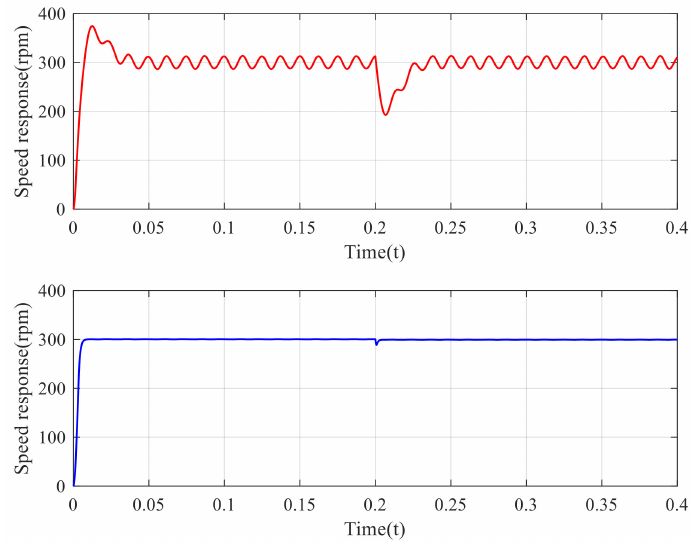
Figure 4. The speed response results without compensation and with compensation in low speed condition (the blue line indicating the speed response results with compensation, and the red line indicating the speed response results without compensation).